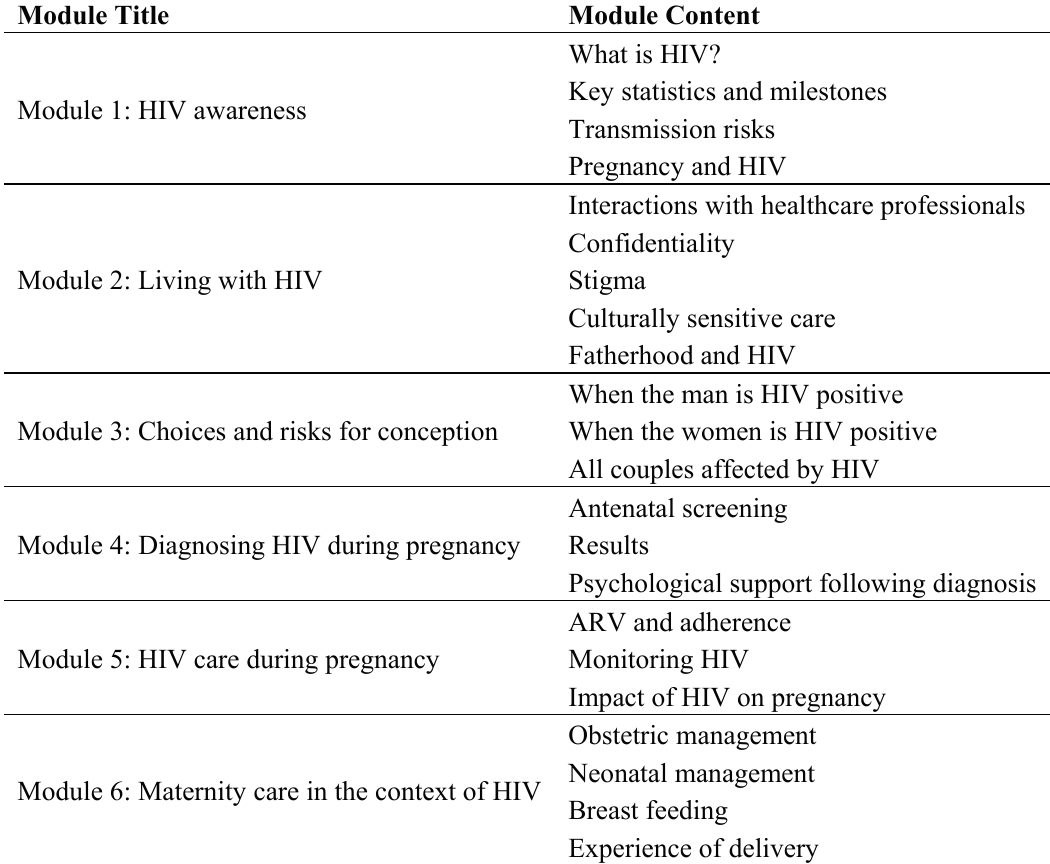
Table 1. Outline of the six modules in the eLearning